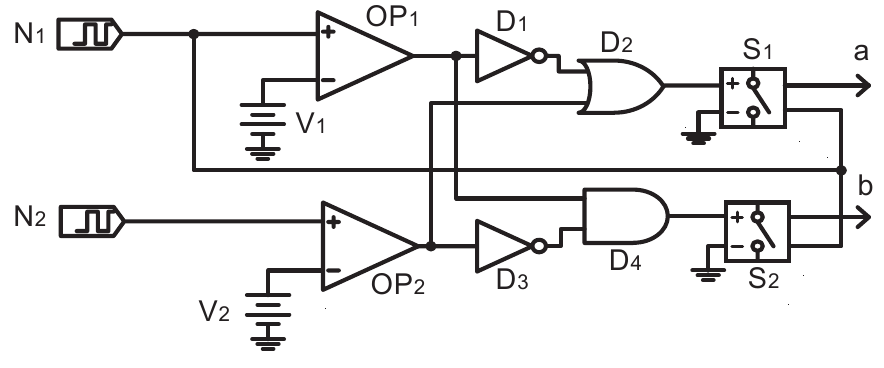
Figure 5. Stimulus judgement module. OP 1 and OP 2 are comparators. V 1 = 2.99 V, V 2 = − 0.1